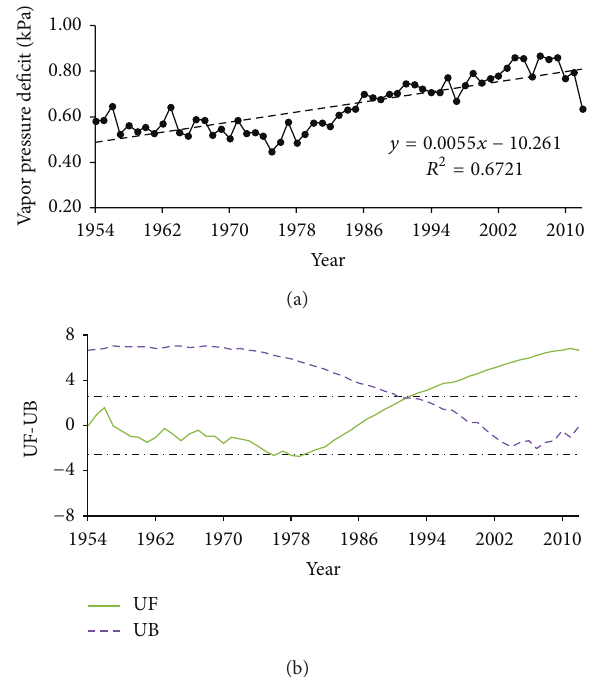
Figure 7: Temporal trend of the mean vapor pressure deficit (a) and the trend results from the Mann-Kendall method (b).